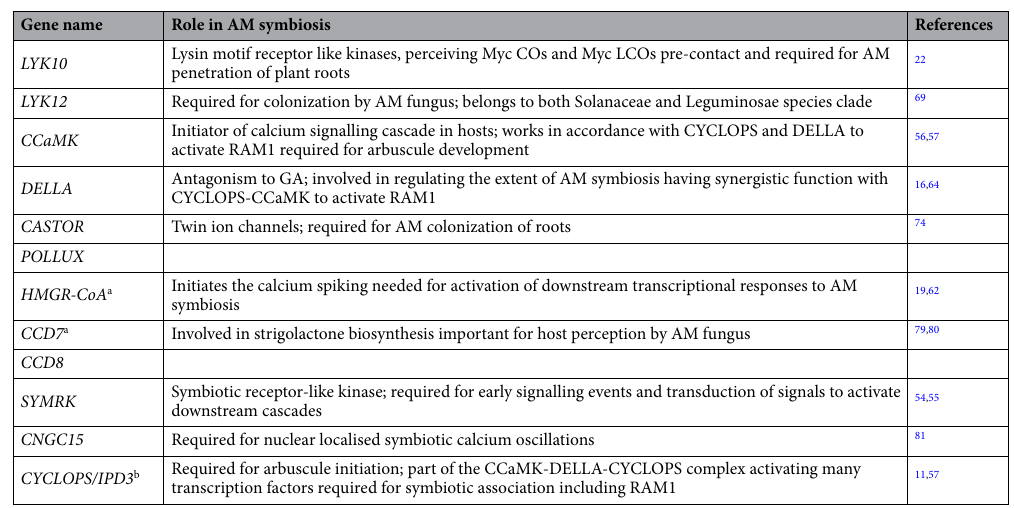
Table 2. List and symbiotic-role of known gene candidates (set 2) used for phylogenetics. a Literature candidates found in transcriptomics data. b Absent in non-host proteomes (not used in further